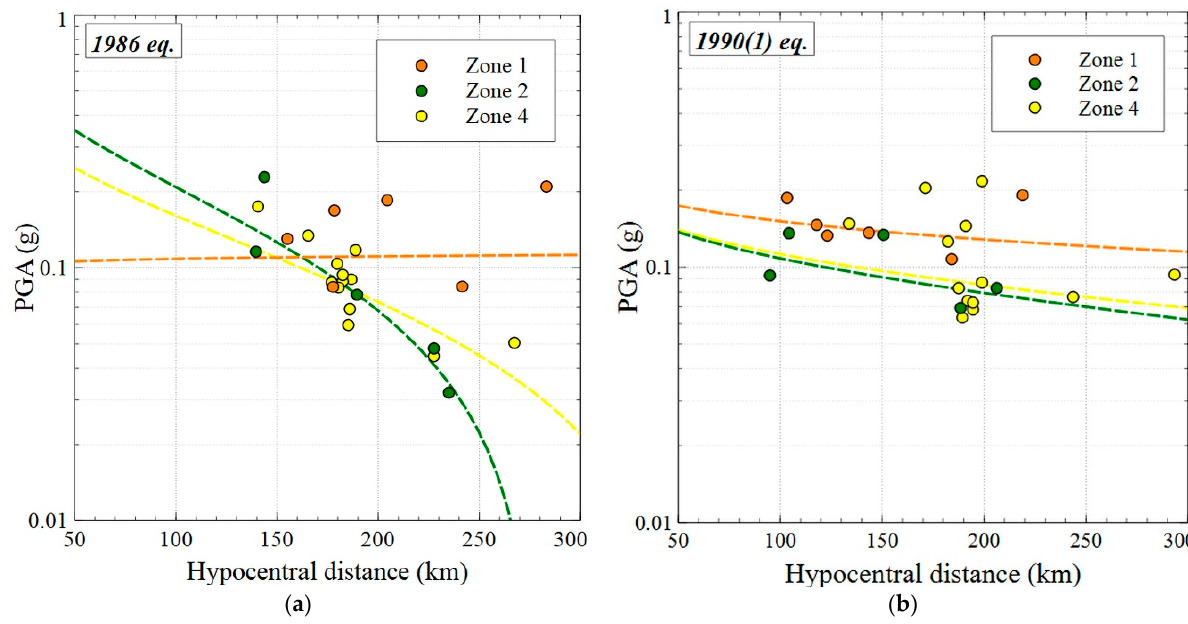
Figure 6. Comparison between the hypocentral distance attenuation curves for peak ground acceleration for: ( a ) the 1986 Vrancea earthquake; ( b ) the 1990(1) Vrancea earthquake. Dashed lines show the corresponding logarithmic fit curves.